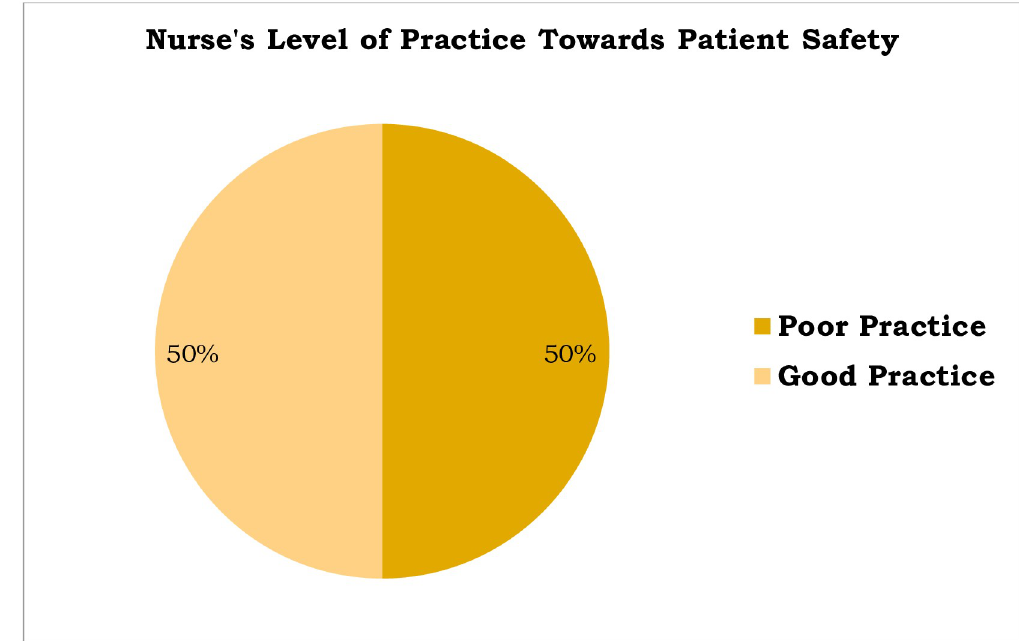
Fig 3. Nurse’s level of practice towards patient safety among nurses working at Asella Referral and Teaching Hospital, Asella, Ethiopia, 2021, [n = 172].